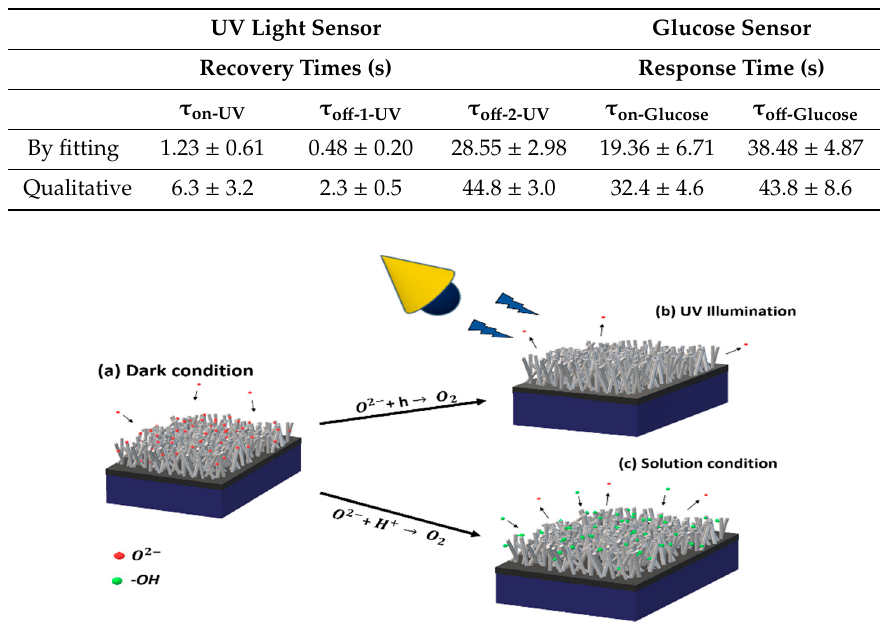
Figure 5. The device under three different conditions: ( a ) in the dark, in which O 2 − atoms (red circles) were adsorbed on the surface of the NW film; ( b ) under UV illumination where O 2 atoms were desorbed; ( c ) the device covered in a solution containing GLU, where O 2 atoms were desorbed and –OH atoms (green circles) then interacted with the surface film. Arrows indicate which chemical–physical reaction took place in the process.